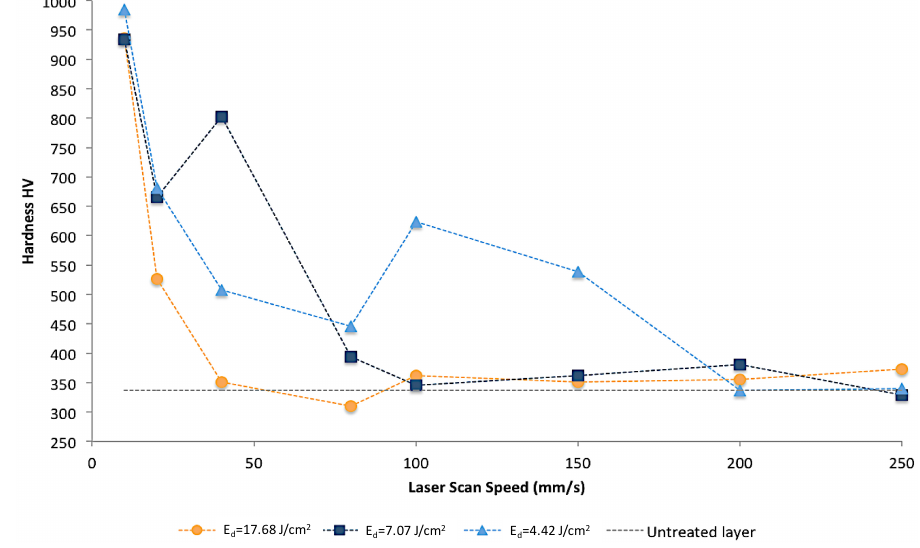
Figure 7. Hardness as a function of laser processing parameters.